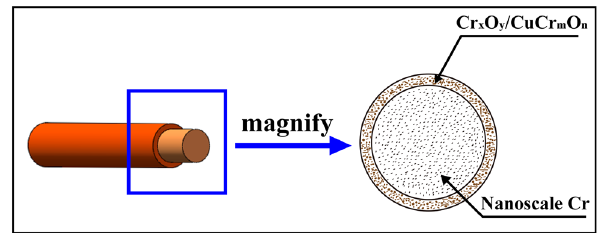
Figure 7: Diagrammatic representation of the prepared Cu – Cr – Ti gradient